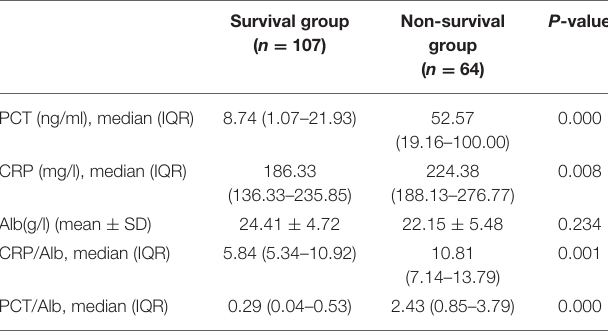
TABLE 2 | Univariate analysis of PCT, PCT/Alb, CRP, and CRP/Alb between survival and non-survival groups in patients with sepsis-induced